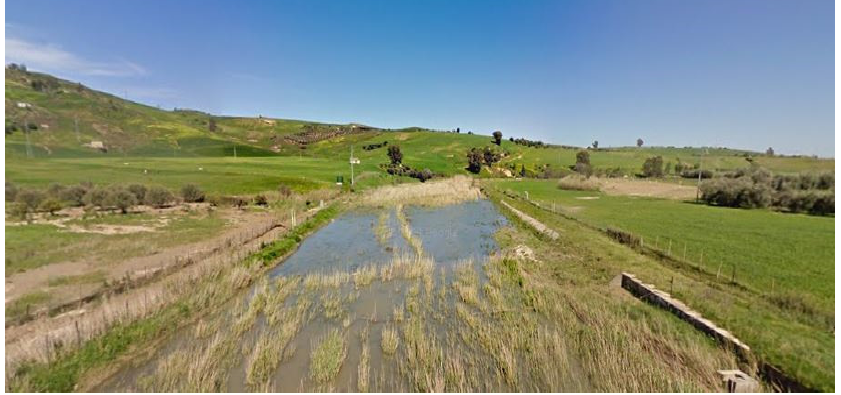
Figure 10. Dittaino River (eastern Sicily).